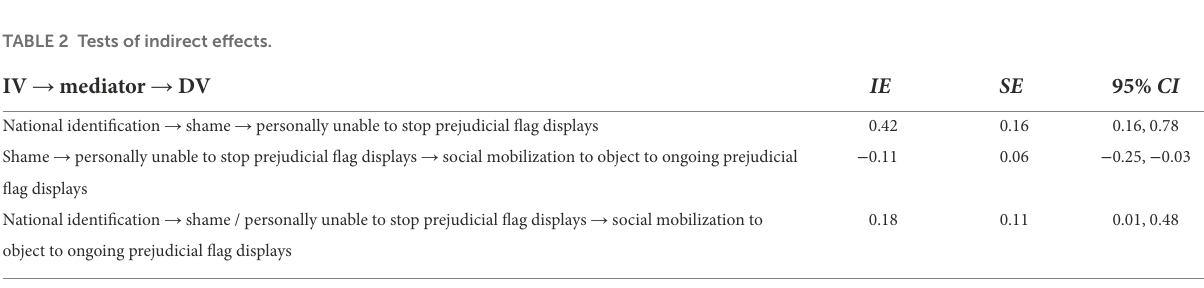
TABLE 2 Tests of indirect